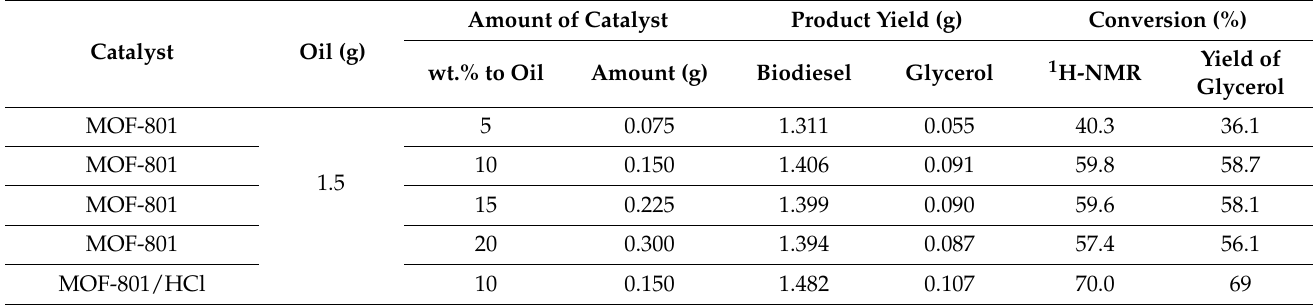
Table 1. The transesterification reactions of UVO in CH 3 OH using different amounts of oil.